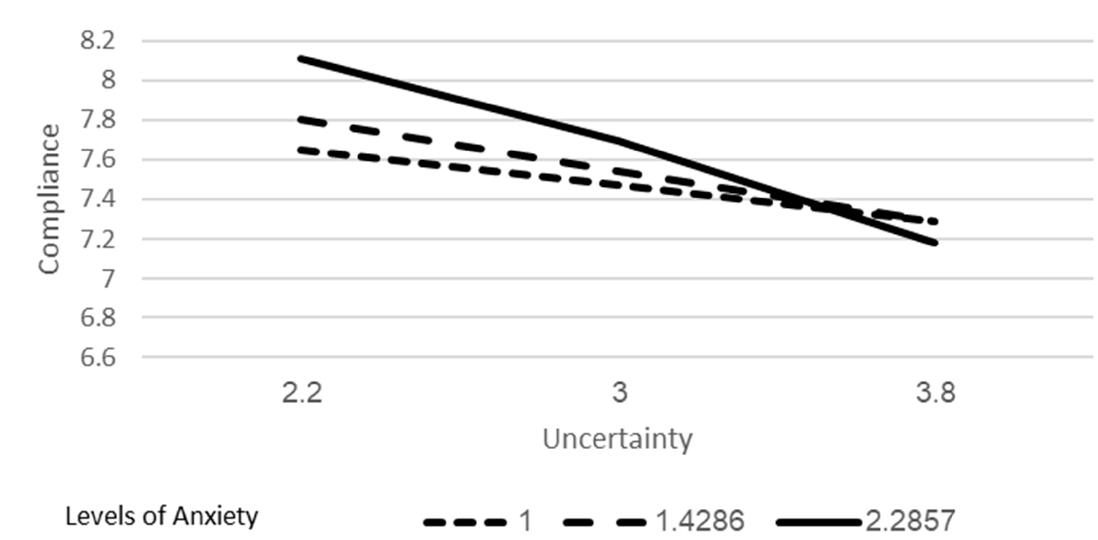
Figure 2. Moderating effect of anxiety on the relationship between uncertainty and compliance.